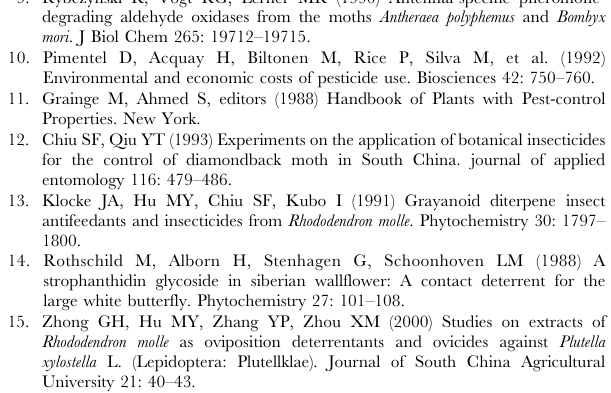
Figure S2 Detection of the relative expression levels of other CSPs in the p. xylostella after RNAi of PxCSP-2 by The data represent the mean values 6 S.E.M of three replicates. ‘*’ means statistically significant difference in expression levels compared to DEPC water ( t -test, p , 0.05). Table S1 Primers for Quantitative Real-Time PCR Measurements of Expression Levels of Selected Genes. Table S2 Primers used in RNAi. Table S3 Primers used for recombinant